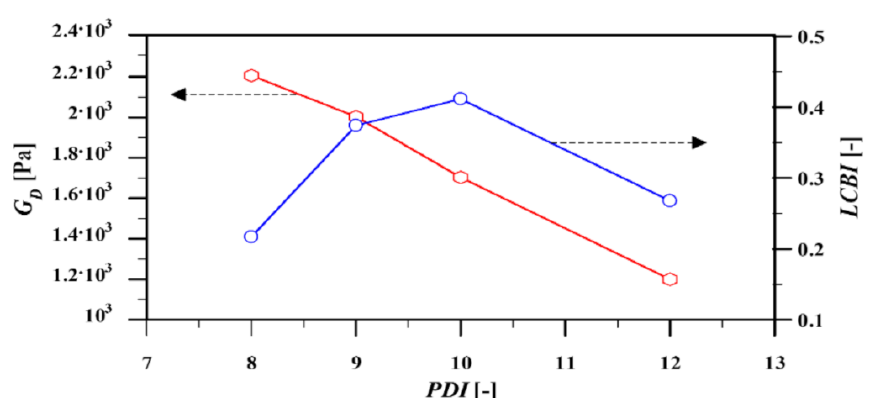
Figure 6. Relationship between dilution modulus ( G D , polydispersity index (PDI), and long chain branching index